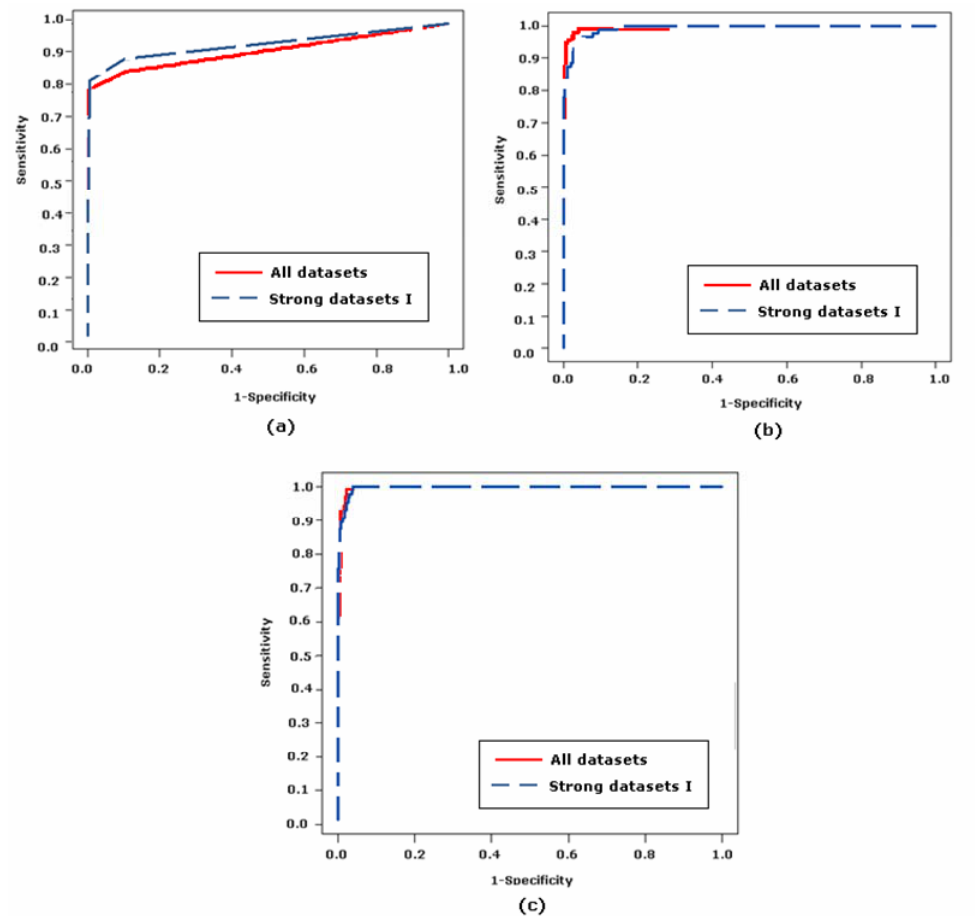
Figure 2. ROC curves obtained from integrating all eight features together, compared with integrating only the strongest 5 datasets. Each panel represents a different machine and statistical learning method (a)KNN, (b) MLP (c)